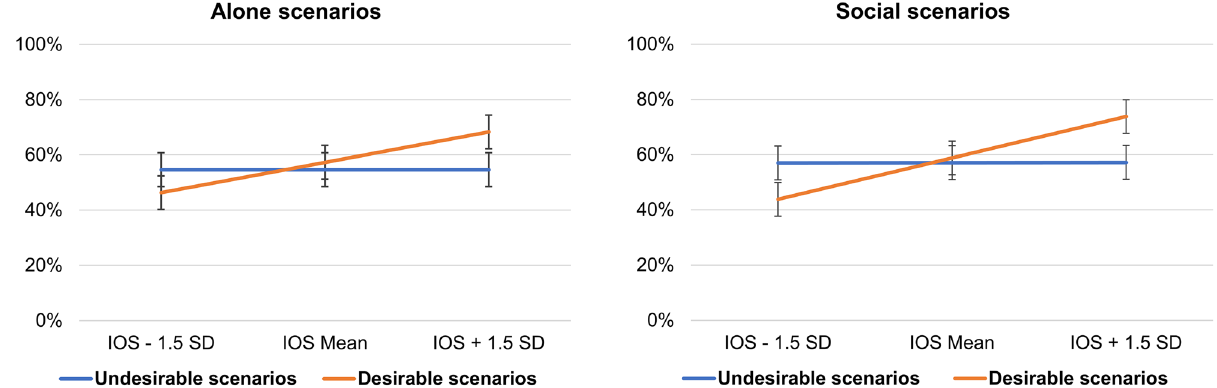
Figure 4. Interaction effect between scores of Inclusion of Others in Self (IOS), valence and sociality. The bars represent 95% confidence intervals.